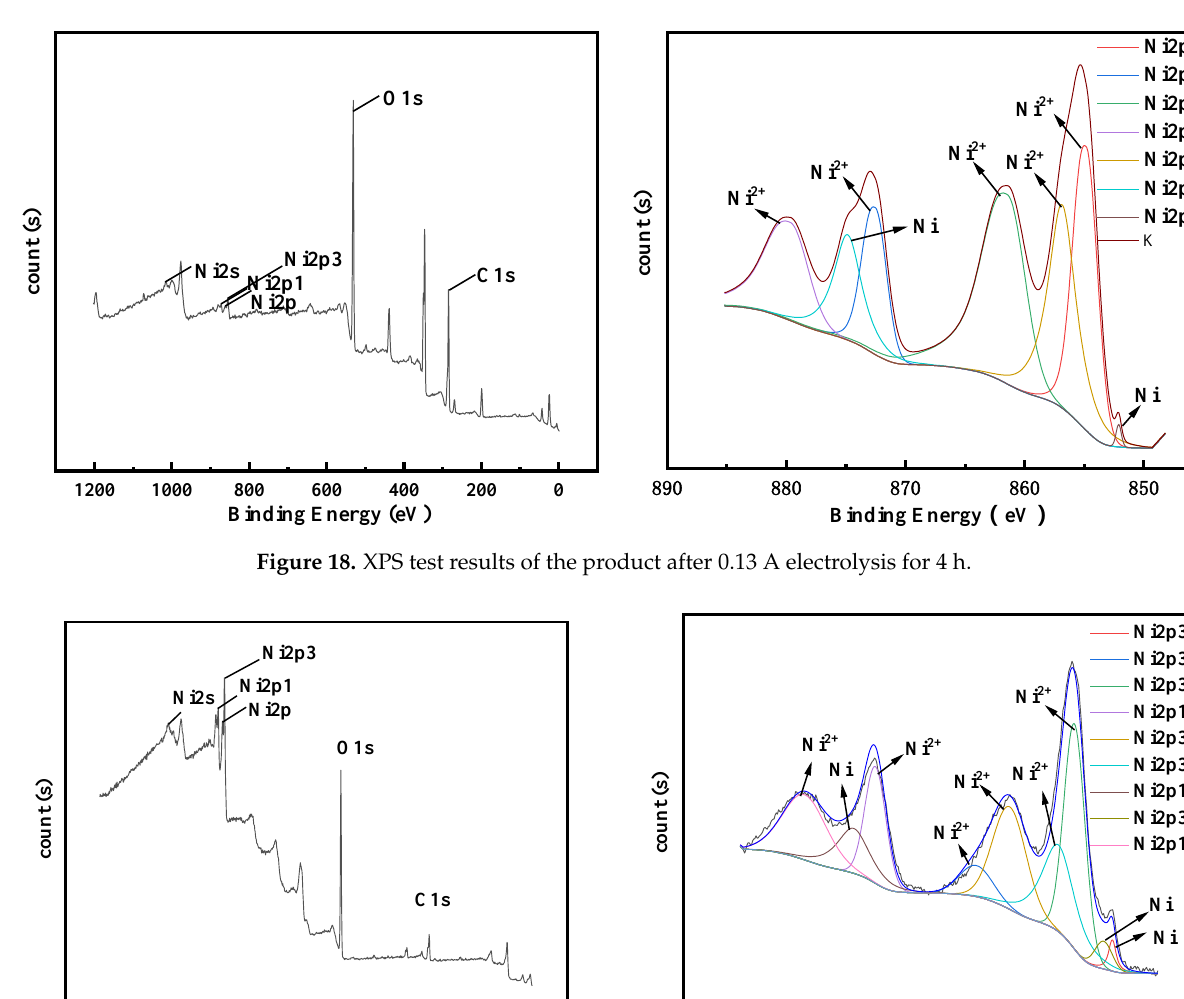
Figure 17. SEM images of electrolyzed products at 1000 times ( a ) and 5000 times ( b ) after 10 h, as well as EDS and surface scan maps at 5000 times (( c ): Ni element ( d ): O element).